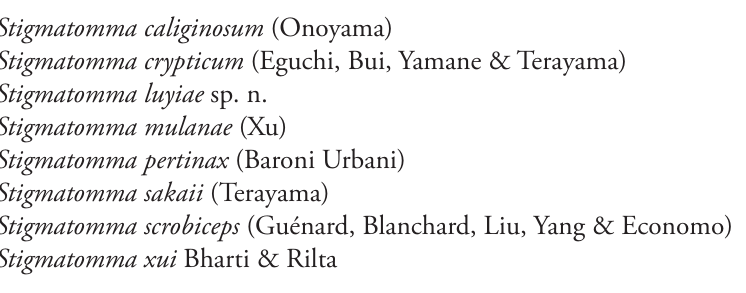
List of known Stigmatomma species in Taiwan Stigmatomma bruni Forel Stigmatomma luyiae sp. n.